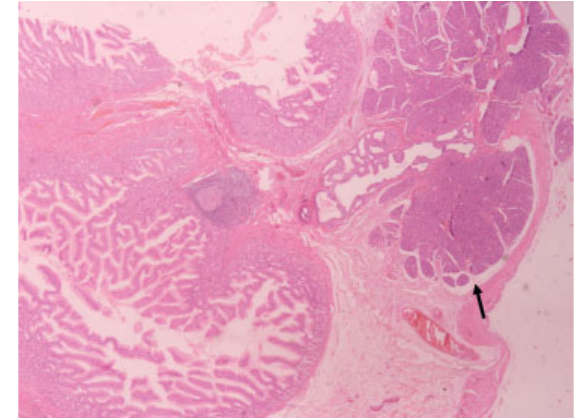
Fig. 4 Intestinal duplication cyst with ectopic pancreatic mucosa (Black